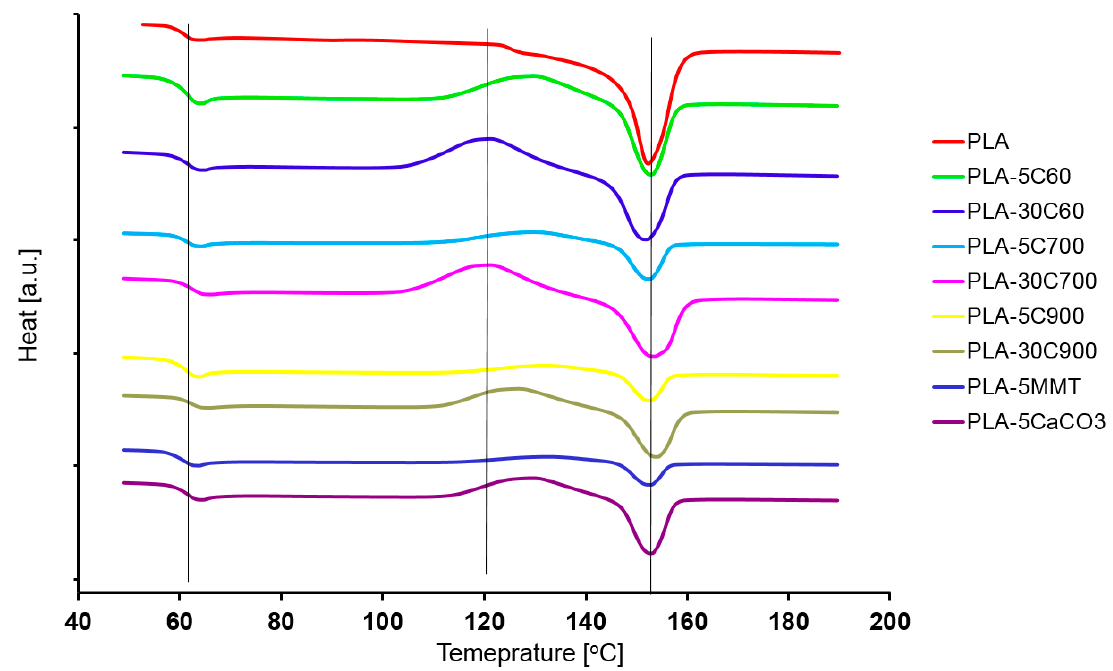
Figure 2. Dynamic Scanning Calorimetry measurements for all of the investigated samples.